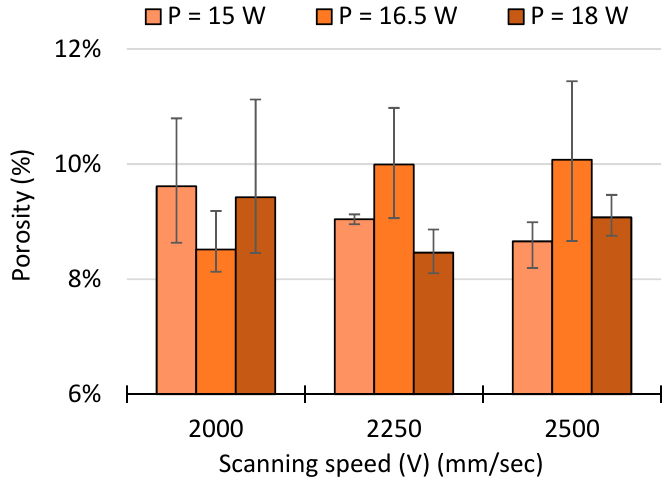
Figure 10. Variation of the porosity percentage as a function of the laser power ( P ) and scan speed ( V ).